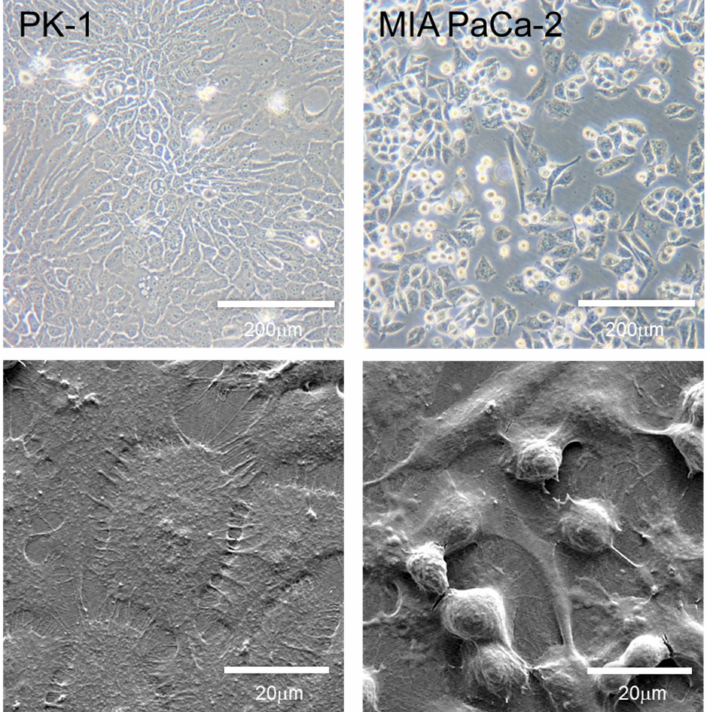
Figure 2. Phase-contrast and scanning electron microscopic images of PDAC cell lines grown in 2D culture